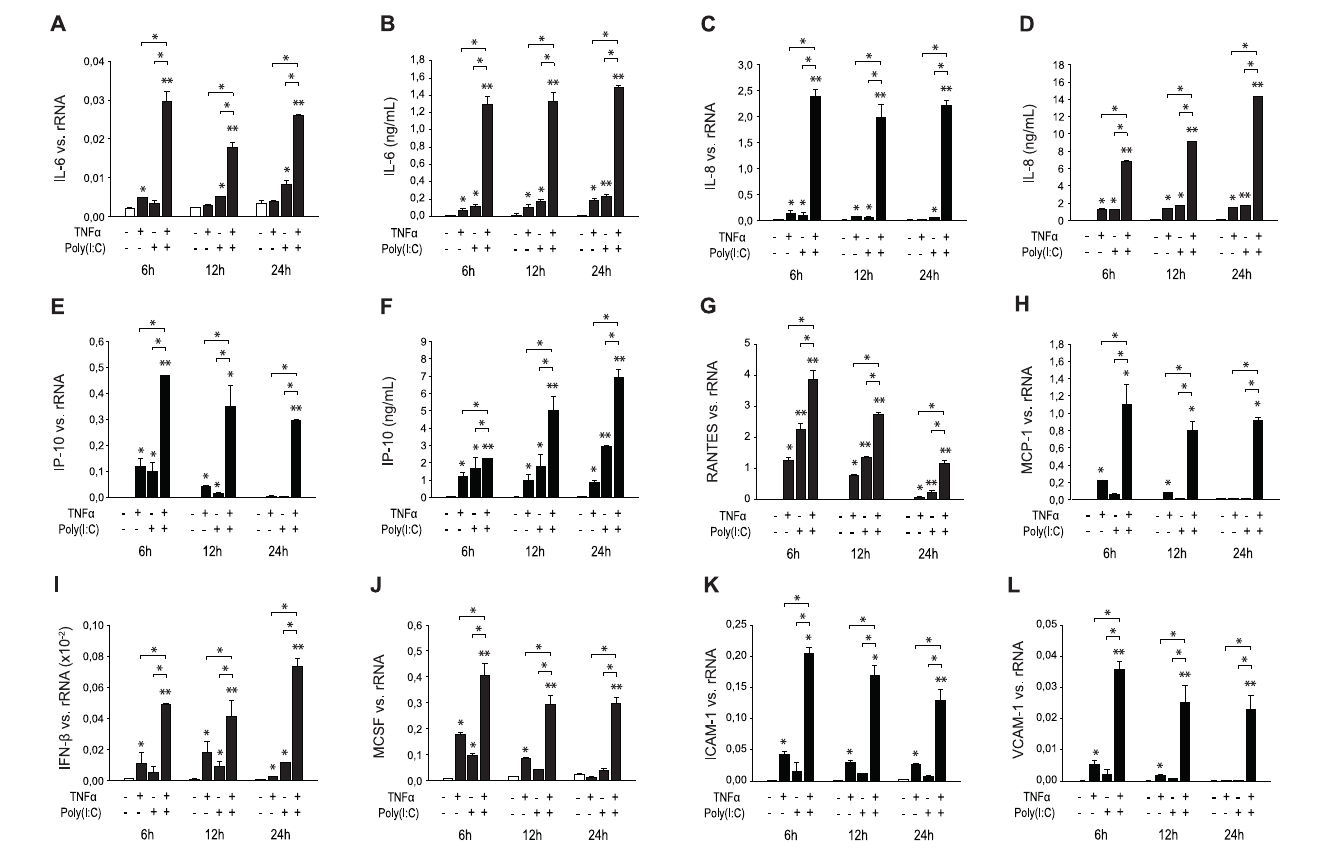
Figure 5. Amplification of poly (I:C)-mediated induction of cytokines, chemokines and adhesion molecules by TNF a . HMEC were grown in culture medium for 24 hours and additionally incubated in medium (basal) for different time intervals (6, 12, 24 hours) or grown in culture medium for 24 hours and additionally incubated with TNF a (TNF a ) for different time intervals (6, 12, 24 hours) or incubated with poly (I:C) for 24 hours and then grown in medium (poly (I:C)) or stimulated with TNF a (poly (I:C) + TNF a ) for different time intervals (6, 12, 24 hours). mRNA expression of selected cytokines and chemokines IL-6 (A), IL-8 (C), IP-10 (E), RANTES (G), MCP-1 (H), IFN- b (I), MCSF (J), ICAM-1 (K) and VCAM-1 (L) was analyzed by RT-PCR. Protein synthesis of selected targets IL-6 (B), IL-8 (D) and IP-10 (F) was also confirmed by ELISA. Results are given as means ¡ SD of three experiments done in parallel for each condition and rRNA served as the reference gene. Comparable results were obtained in two series of independent experiments. Statistically significant differences to the control are depicted with * 5 p # 0.05, ** 5 p #